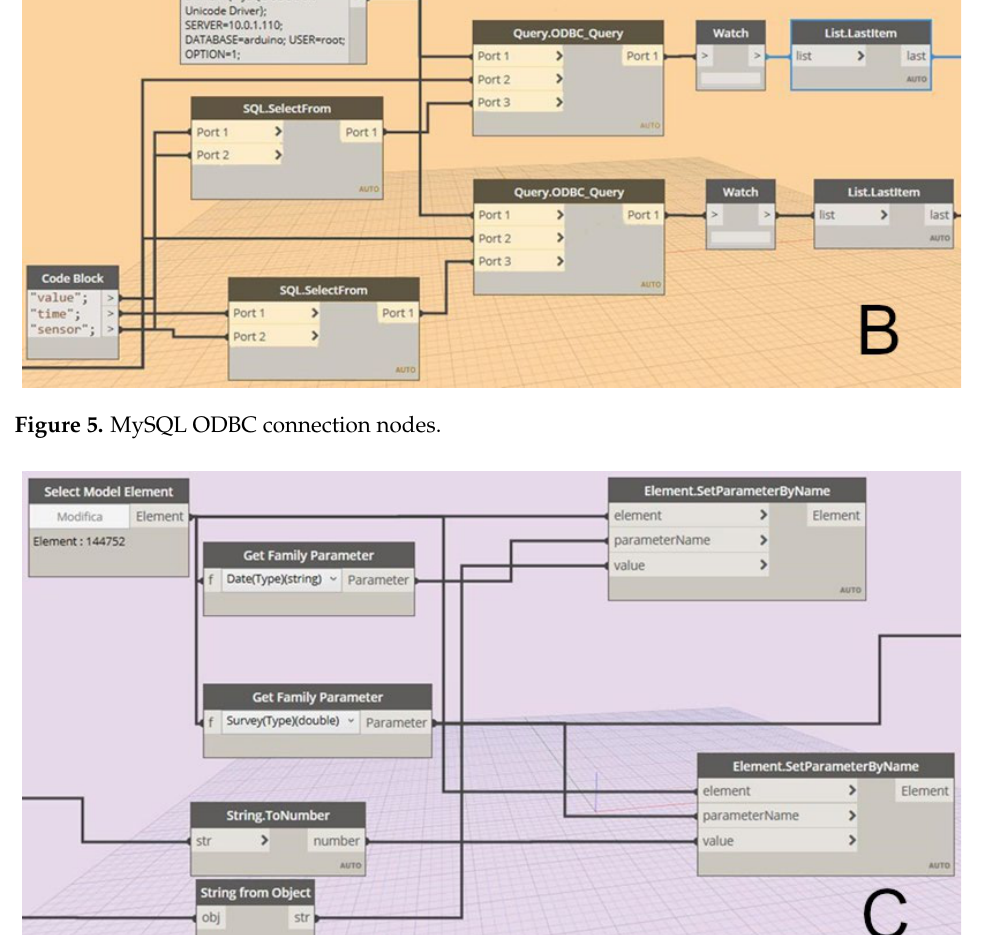
Figure 6. Revit element and parameter-selection nodes.